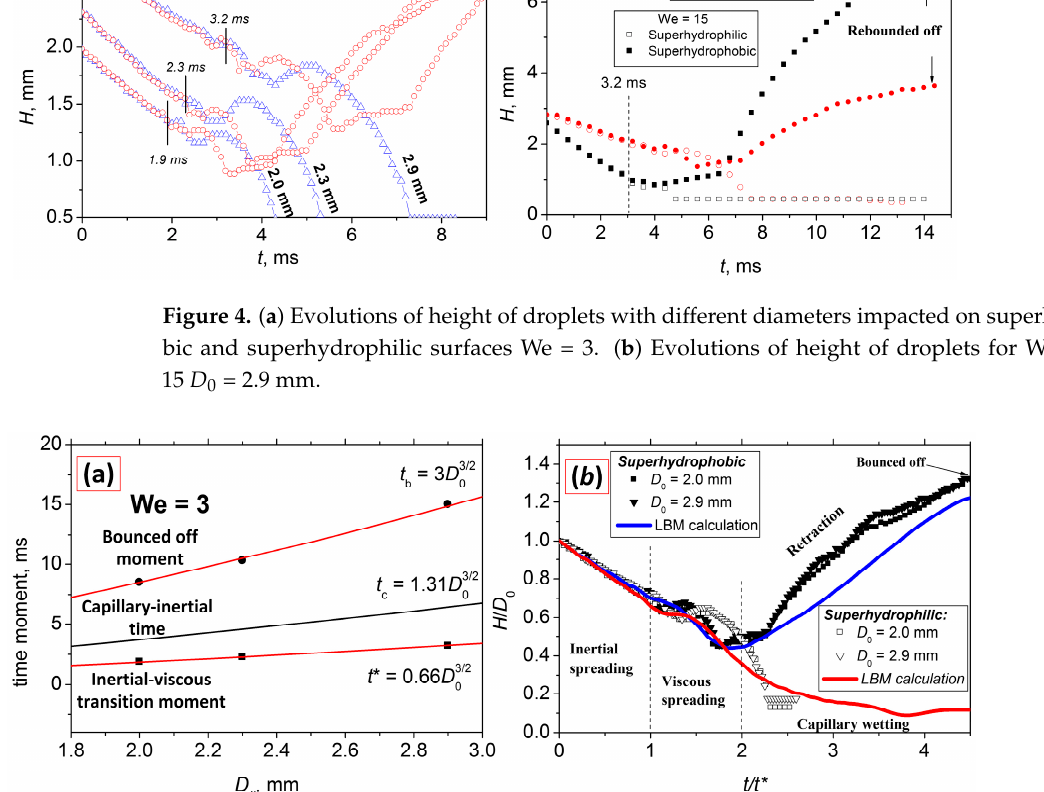
Figure 4. ( a ) Evolutions of height of droplets with different diameters impacted on superhydropho ‐ bic and superhydrophilic surfaces We = 3. ( b ) Evolutions of height of droplets for We = 3 and 15 D 0 = 2.9 mm.